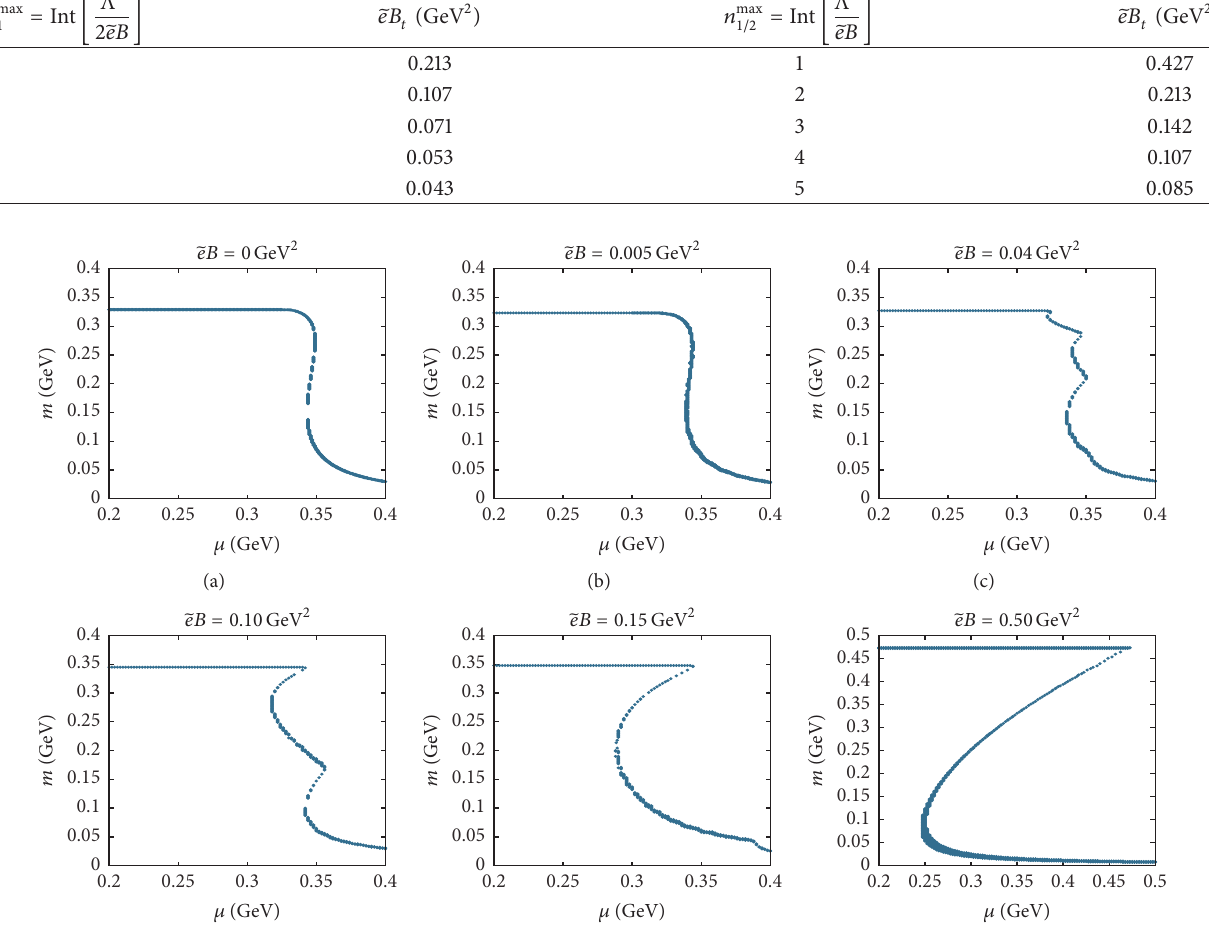
plot 𝜇 𝑐 as a function of ̃𝑒𝐵 . We observe that 𝜇 𝑐 oscillates with ̃𝑒𝐵 with dips whenever Λ 2 /(2|𝑎|̃𝑒𝐵) takes an integer value, following the Shubnikov de Haas-van Alphen